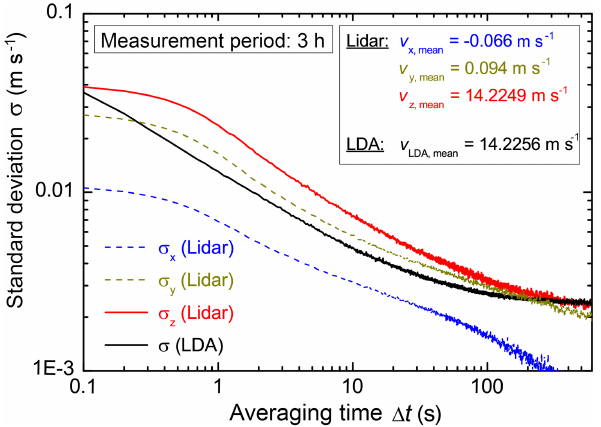
Figure 12. Long-term comparison measurement of the PTB lidar and the LDA reference standard in the wind